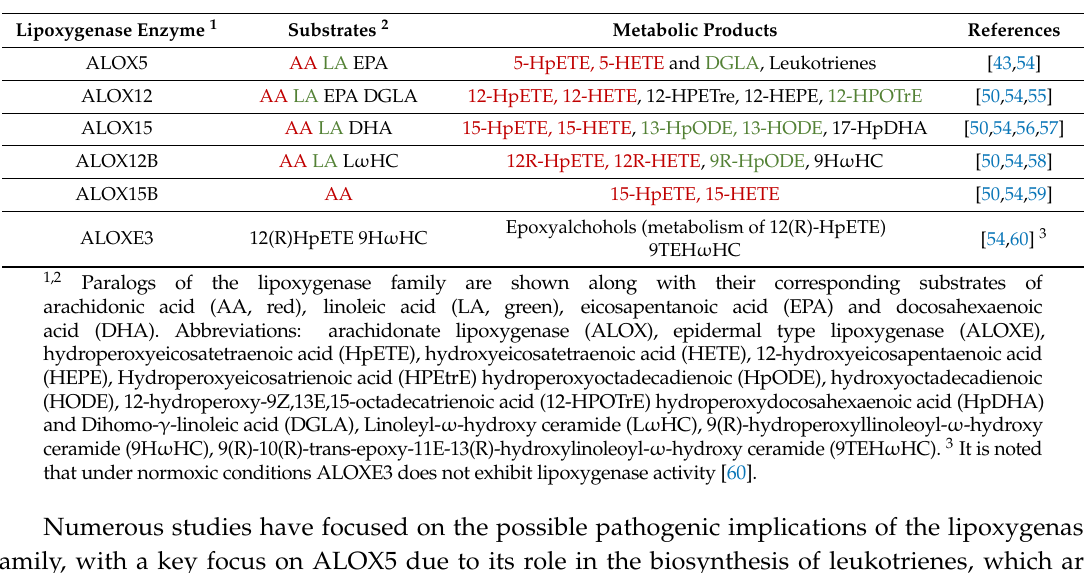
Table 1. Paralogs and metabolites of the family of human lipoxygenase